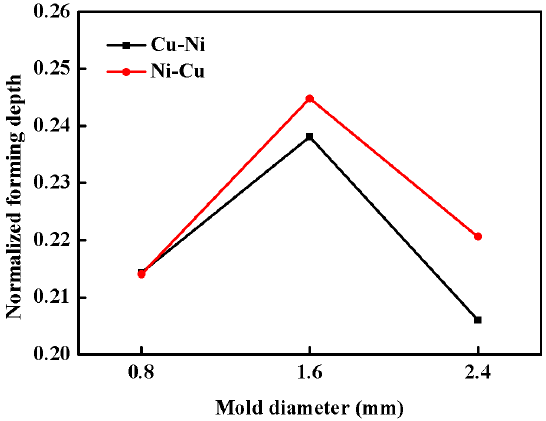
Figure 13. Feature size effect on normalized forming depth (laser energy was 835 mJ).